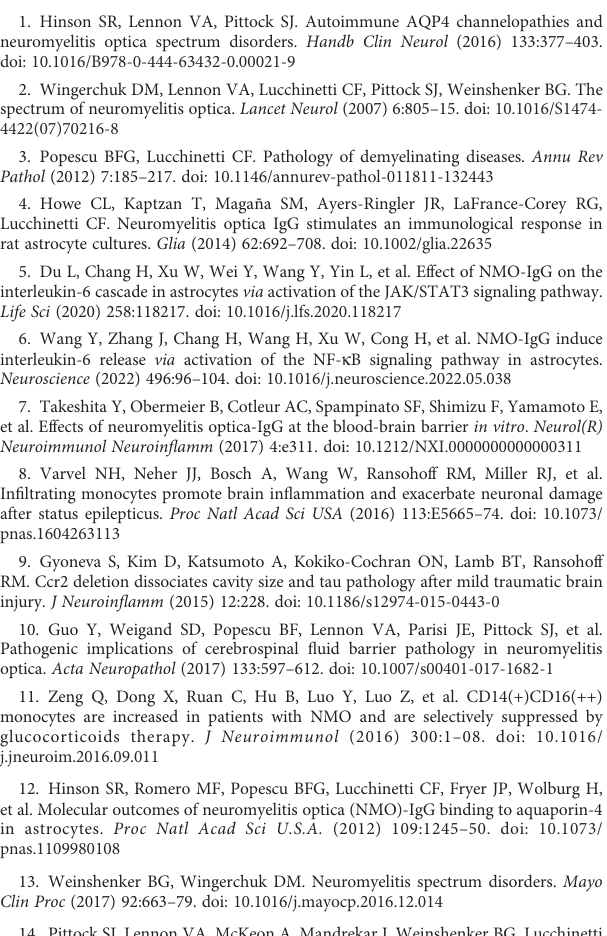
SUPPLEMENTARY FIGURE 2 JAK1 and p42/40 signaling pathways are involved in NMO-IgG-induced damage in astrocytes.